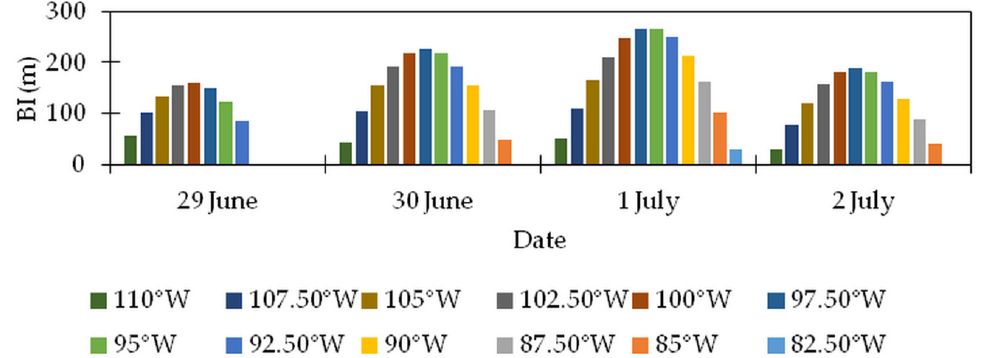
Figure 4. Time evolution of the absolute value of the BI between 29 June and 2 July 2007, for every 2.5° of longitude in the 110° W–82.50° W range. The BI on 1 July 2007 reached -266.83 m at 95° W, which was the overall maximum absolute value within the analyzed period. Values expressed in meters.